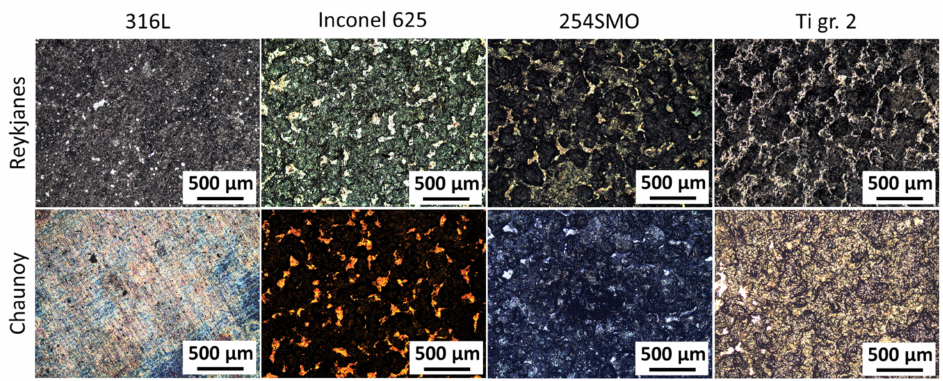
Figure 6. Optical topography images where the above line has the samples tested in Reykjanes and below are the samples tested in Chaunoy.